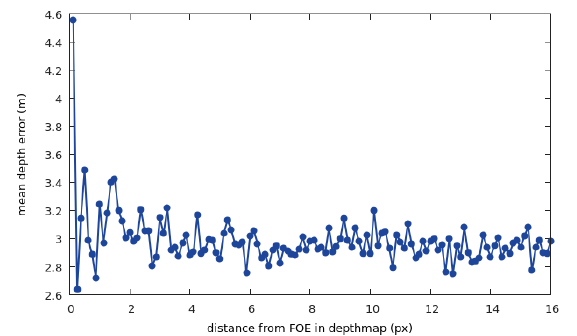
Figure 5. mean depth error as a function of distance from FOE, for DepthNet 64